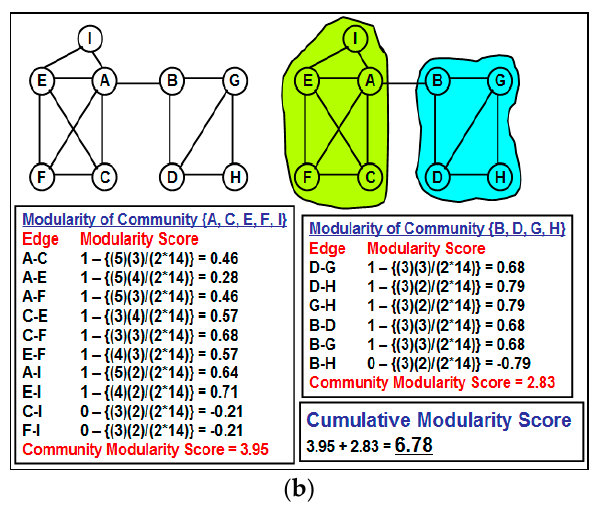
Figure 3. Motivating example to illustrate the impact of not choosing an appropriate threshold value for the neighborhood overlap score to partition the Network into communities. ( a ) A greedy approach of removing all edges with NOVER score less than or equal to the threshold; ( b ) A better partition of the vertices into communities with a relatively larger cumulative modularity score.